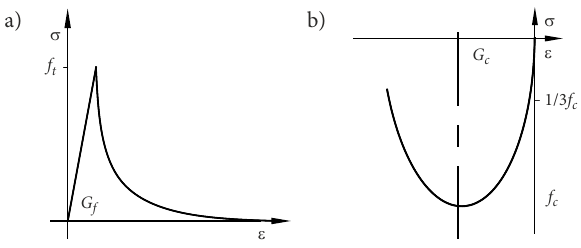
Figure 5. Graphs of masonry units‘ material parameters in numerical model: a) exponential function; b) parabolic function (according to TNO Diana, 2011) Figure 6. Failure mode of mortar joint in numerical